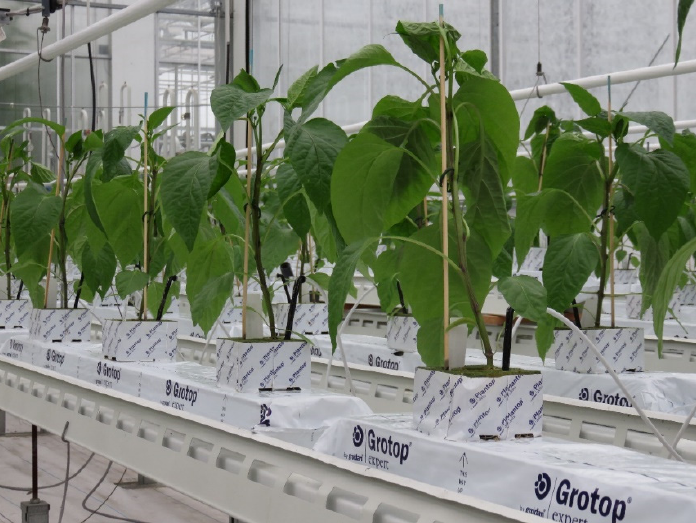
Figure 1. Blocks containing sweet pepper plants placed on top of the stone wool mats in holes in the plastic foil; photo taken before the start of the experiment. Each plant receives irrigation water, pesticide, and nutrients via drip irrigation. Water is collected in drain troughs below the stone wool mats.